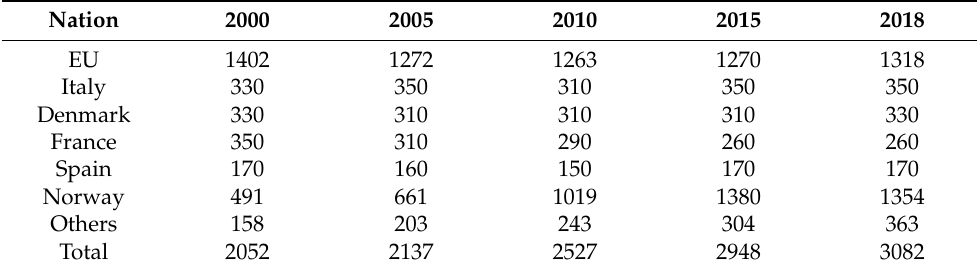
Table 6. Main rainbow trout producing nations in Europe ( × 100 t).